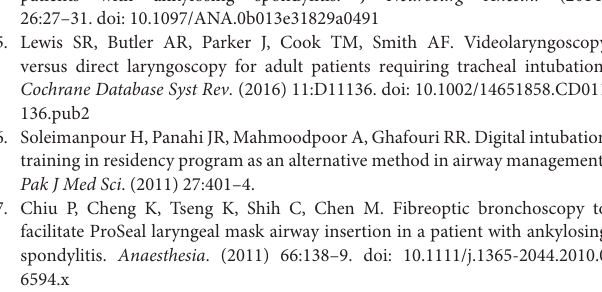
and provides good visualization of the pharynx ( Figure 2II